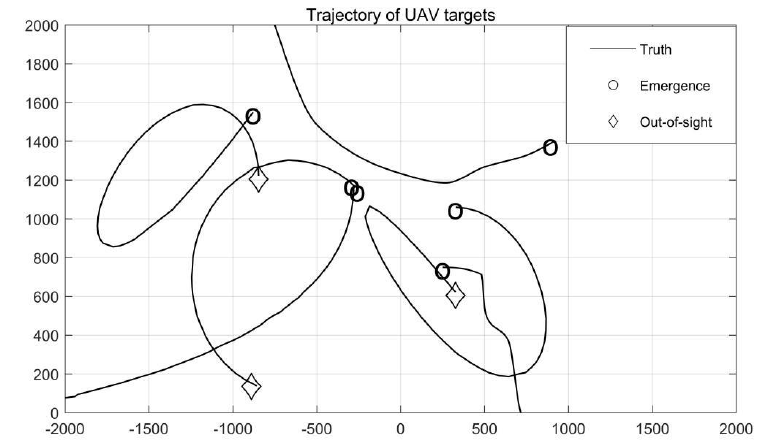
Figure 3. Real trajectories of UAVs.